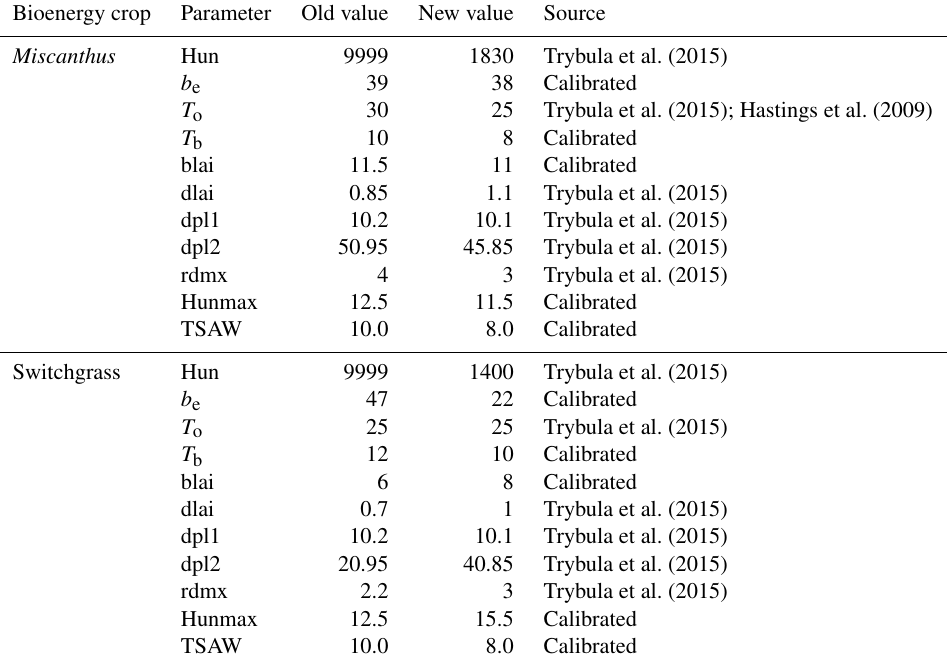
Table 2. Parameters set in the enhanced H08 model.